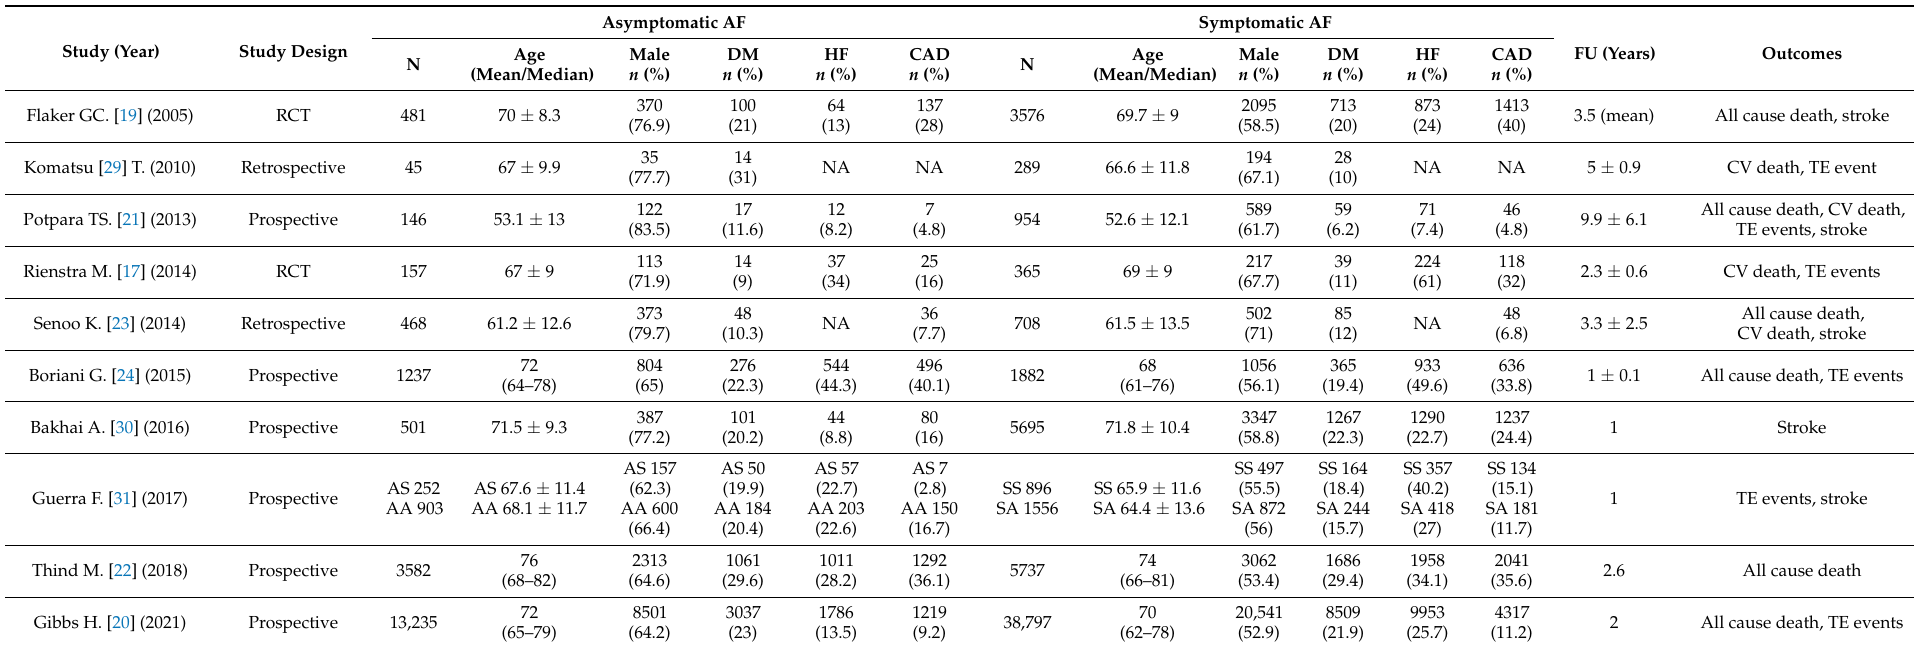
Table 1. Studies design and baseline characteristics of asymptomatic and symptomatic AF